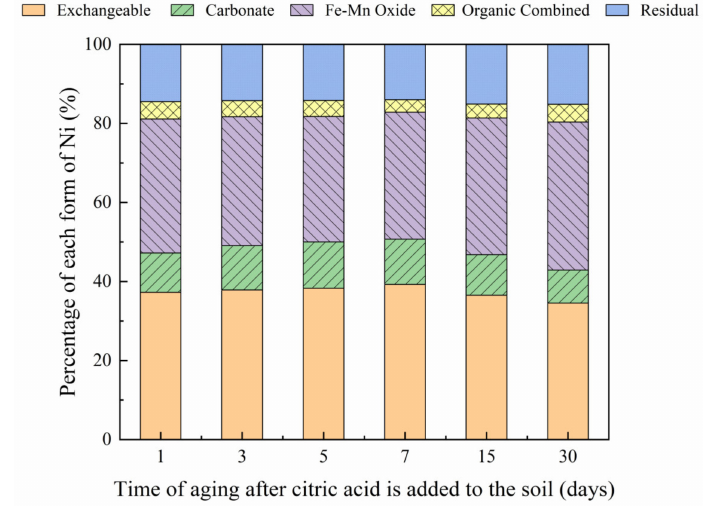
Figure 12. Distribution of different Ni forms at different aging times (1, 3, 5, 7, 15, and 30 days) after the addition of citric acid to Ni-300 mg/kg contaminated soil.